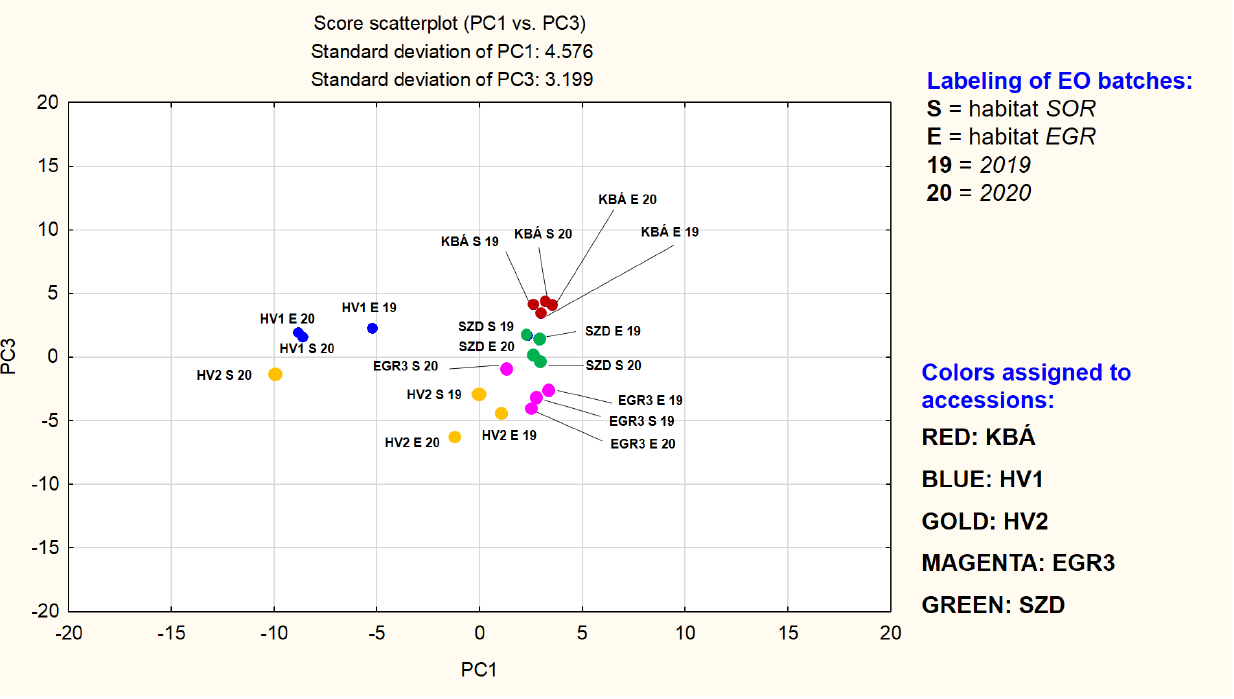
Figure 2. Scatterplot of PC1 vs. PC2.